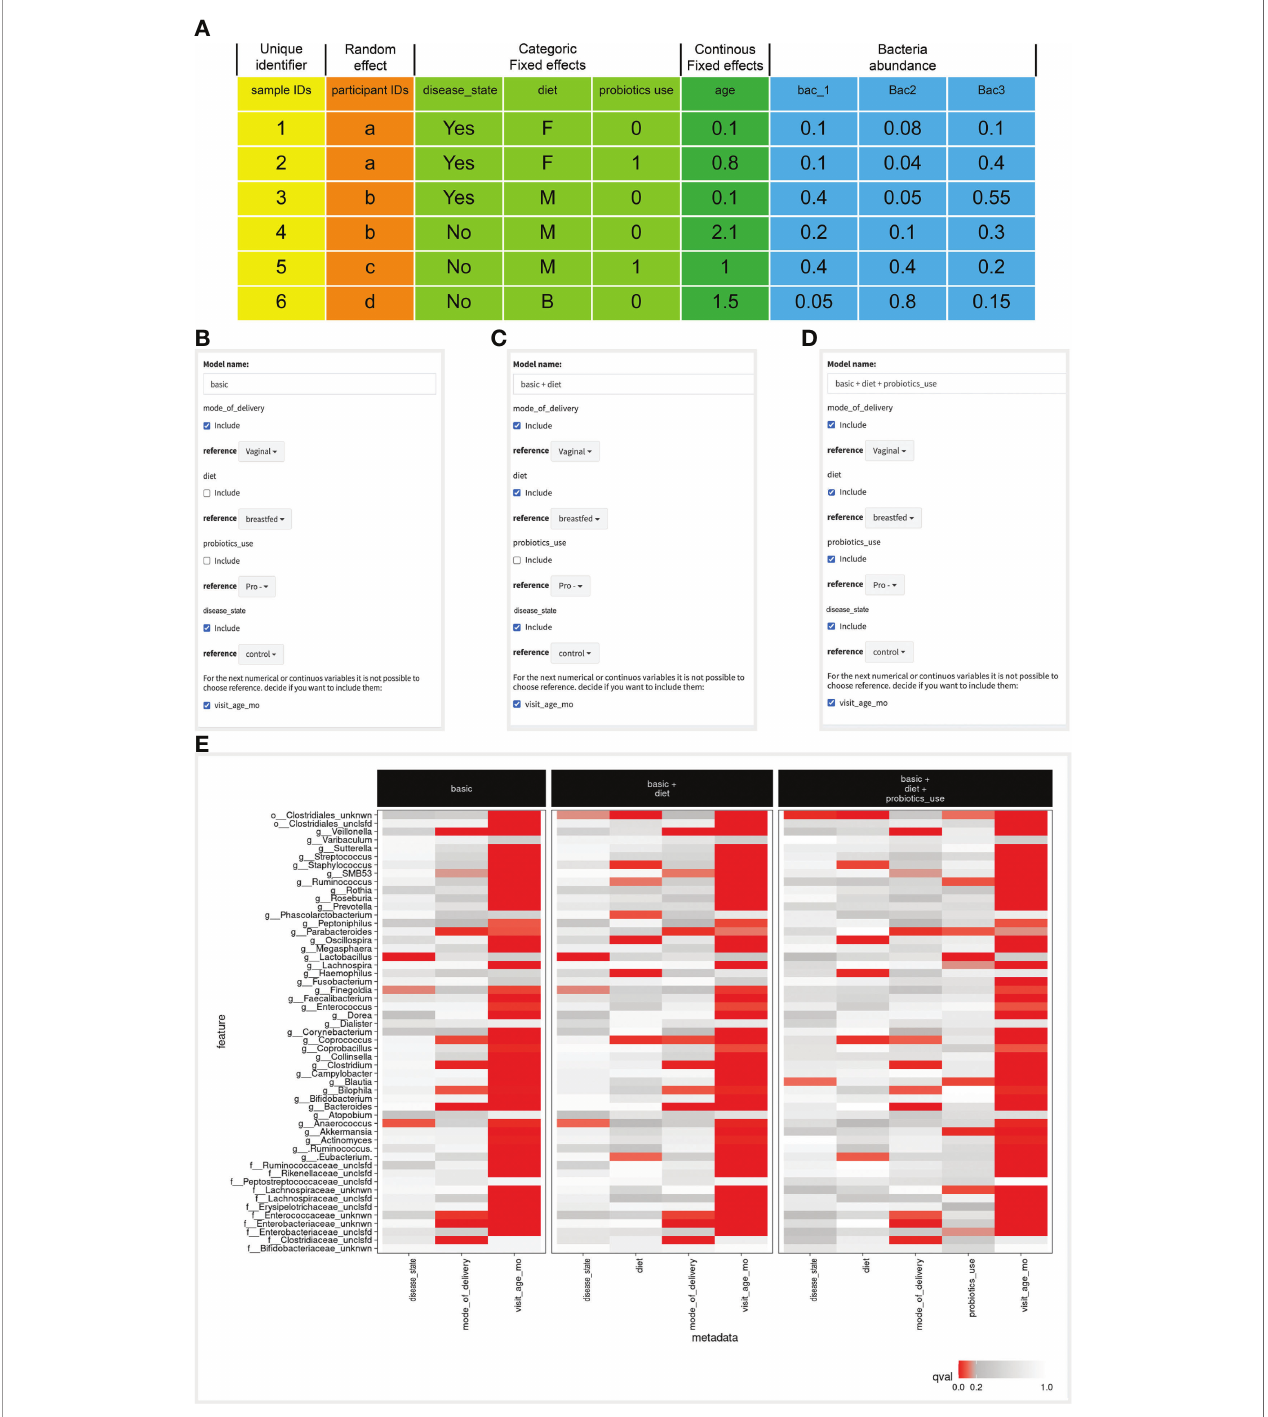
FIGURE 2 | De fi ning the variables, constructing the models and comparing the results. (A) Input fi le example, where column colors represent different variable types (appear at the top of the table), and the fi rst row is the table ’ s header. (B – D) Screenshots of the model construction step. Checkbox values next to each variable indicate if it is included in each model, and the reference value for each variable is selected in the dropbox. The last variable, named ‘ visit_age_mo ’ is de fi ned as a continuous variable, therefore its reference is assigned as zero. (E) A heatmap showing the birds-eye view of all signi fi cant results across all models, from the MaAsLin2 analysis. Each box represents a model, rows are microbial features, and columns are model variables. Each entry in the heatmap is colored by the signi fi cance of the association of the speci fi c microbial feature with the speci fi c model